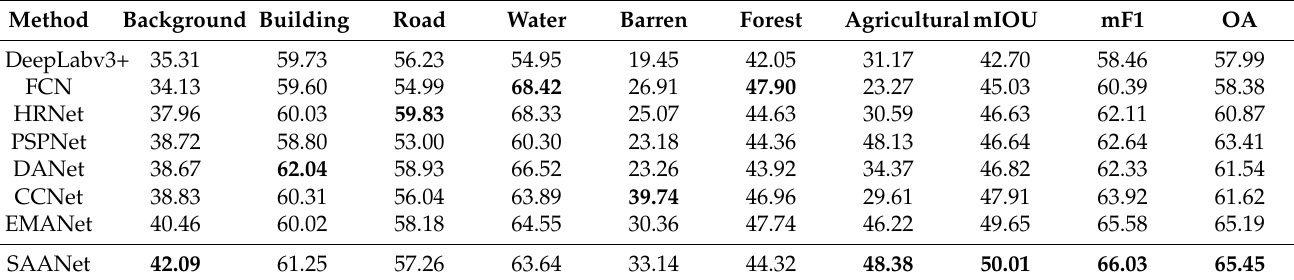
Table 3. Comparisons of different networks on LoveDA Urban dataset. Note that we choose the IOU as the metric of each category. The best results are shown in